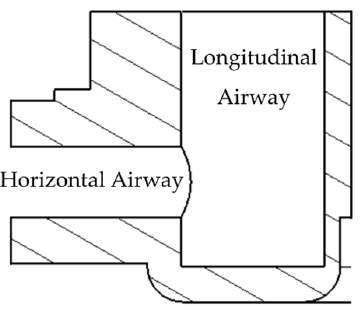
Figure 4. Bending area of the air